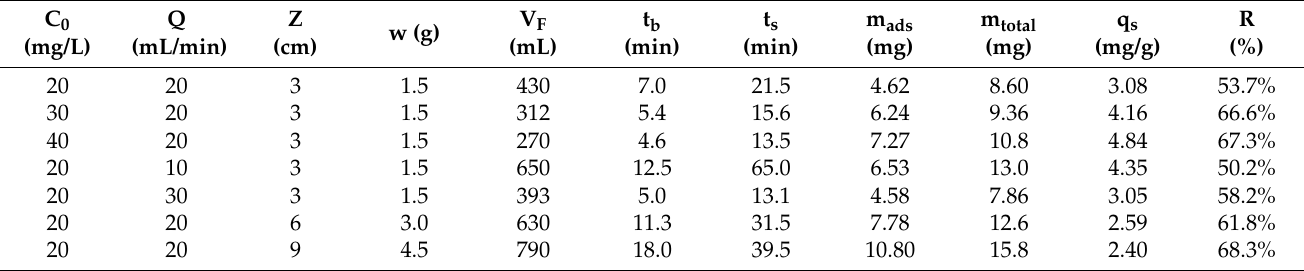
Figure 5. Breakthrough curves of F − adsorption by FBC varying ( a ) F − concentration; ( b ) flow rate; ( c ) bed height. Table 1. Performance parameters of FBC from the breakthrough curves.